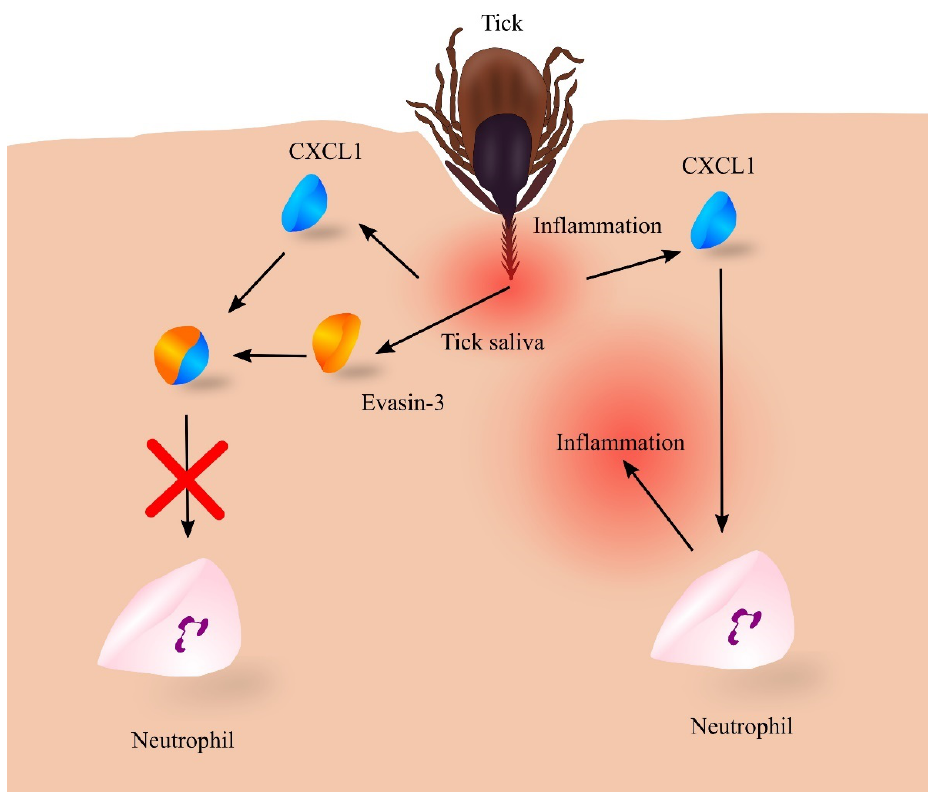
Figure 6. Role of evasin-3 in inhibiting the inflammatory response to tick feeding. Tick feeding leads to inflammatory responses, which induce an increase in the expression of chemokines including CXC motif chemokine ligand 1 (CXCL1), which recruits neutrophils to the vicinity of the feeding tick. This leads to even greater inflammatory reactions, itching of the skin, and removal of the tick by the host. However, the tick introduces its saliva into the site of the puncture while feeding, which contains a number of proteins, including evasin-3, which binds to CXCL1, resulting in the loss of its biological properties. No neutrophil recruitment then occurs and the tick can feed unnoticed for some time. Source: own